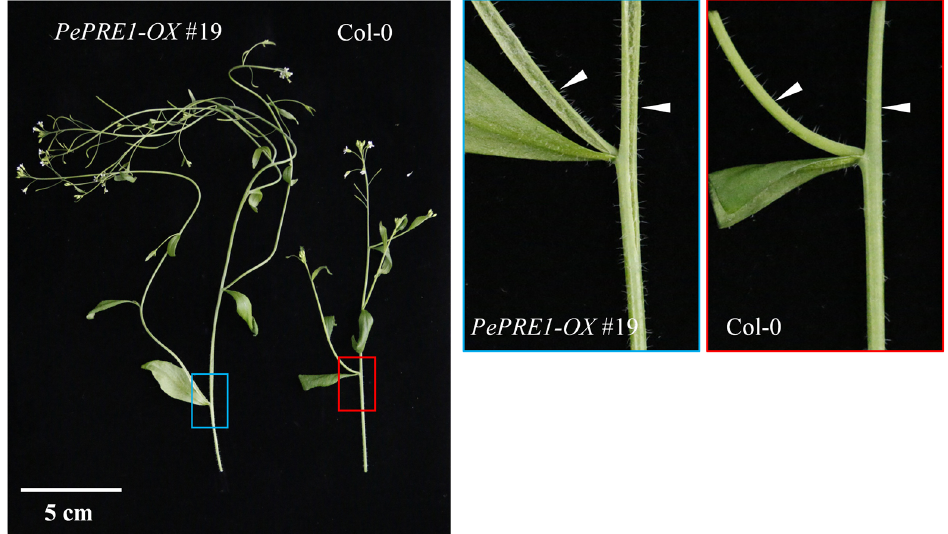
Figure A2. The morphology of T1 transgenic plants overexpressing PePREs ( 35S:: PePRE1-GFP #19 phenotype) in Arabidopsis . The plants were grown in a growth room for 4 weeks.